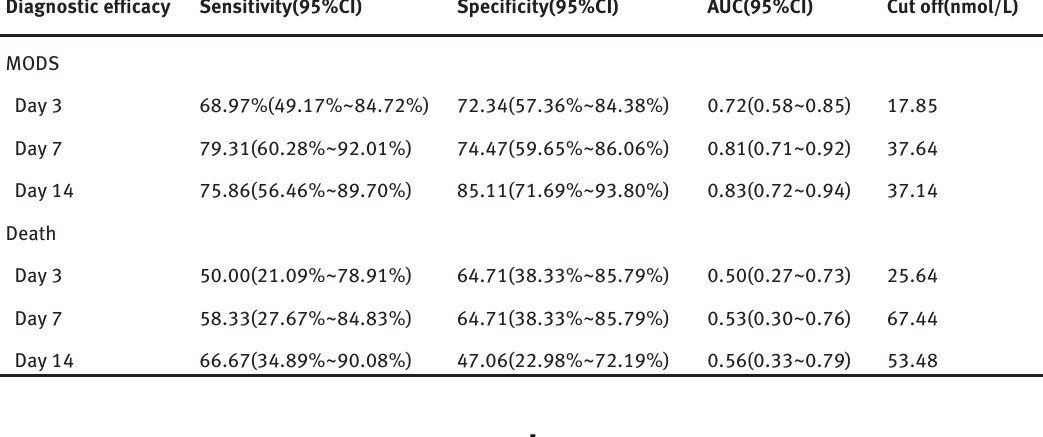
Table 3: The diagnostic performance of serum neopterin for (MODS) and death. Diagnostic